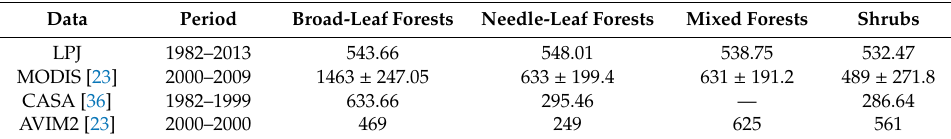
Table 2. Comparison of mean annual forest NPP from the LPJ model with that of other data (unit: gC · m − 2 · y − 1